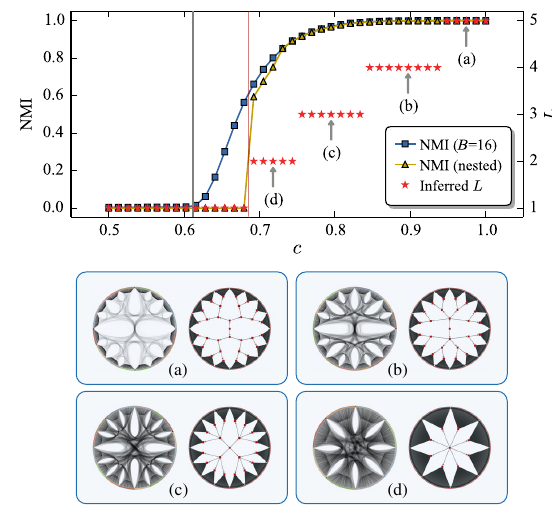
FIG. 4. Top: NMI between the inferred and true partitions for network realizations of the nested PP model described in the text with B 1 ¼ 2 , L ¼ 5 , h k i ¼ 20 , and N ¼ 10 4 , as a function of the assortativity strength c , both via the standard stochastic block model with B ¼ 16 and the nested variant with unspecified parameters. The star symbols ( ⋆ ) show the value of L for the inferred hierarchy. All points are averaged over 20 independent realizations. The gray vertical line marks the detectability thresh- old when B is predetermined, and the red line when the nested model fails to detect any structure. Bottom: Example hierarchies inferred for the values of c indicated in the top panel. The left- hand image shows the network realization itself, and the right-hand one the hierarchical structure [the planted hierarchy corresponds to the one in